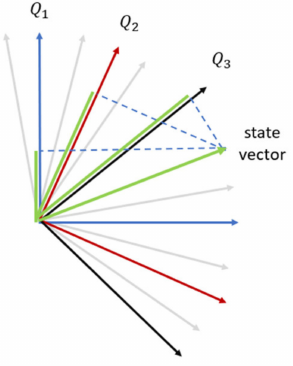
Figure 1. There are three questions, Q 1 , Q 2 , and Q 3 , each with its own basis state e 1 , e 2 , and e 3 together with their corresponding orthogonal vectors e 1 , e 2 , and e 3 , where each pair e i and e i spans a two-dimensional plane. e 1 and e 1 are colored blue, e 2 and e 2 are colored red, and e 3 and e 3 are colored black. The gray vectors, together with their orthogonal vectors, can potentially represent some additional other questions rather than the ones we presented before. The green vector represents the customer data during their digital purchases, and the dashed lines represent the projection on each of the three questions, which indicates the probability of each of these questions’